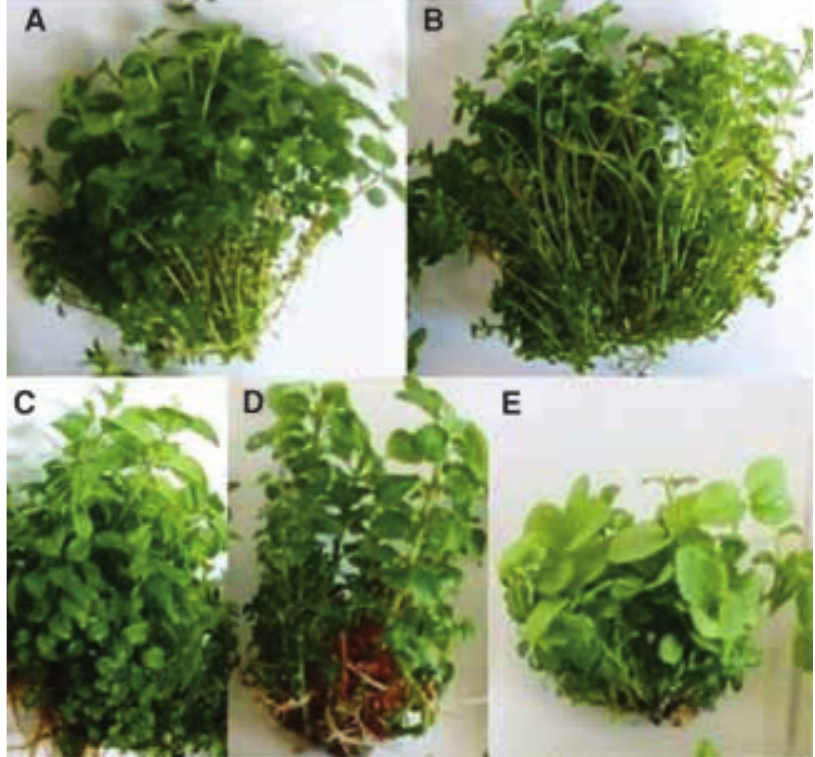
Figure 3. In vitro shoots of Amelanchier canadensis ‘Rainbow Pillar’ developed on media gelled with either 6.8 g l -1 fi brous agar-agar (A); or 20.0 g l -1 Guar gum (B); or 50.0 g l -1 wheat starch (C);